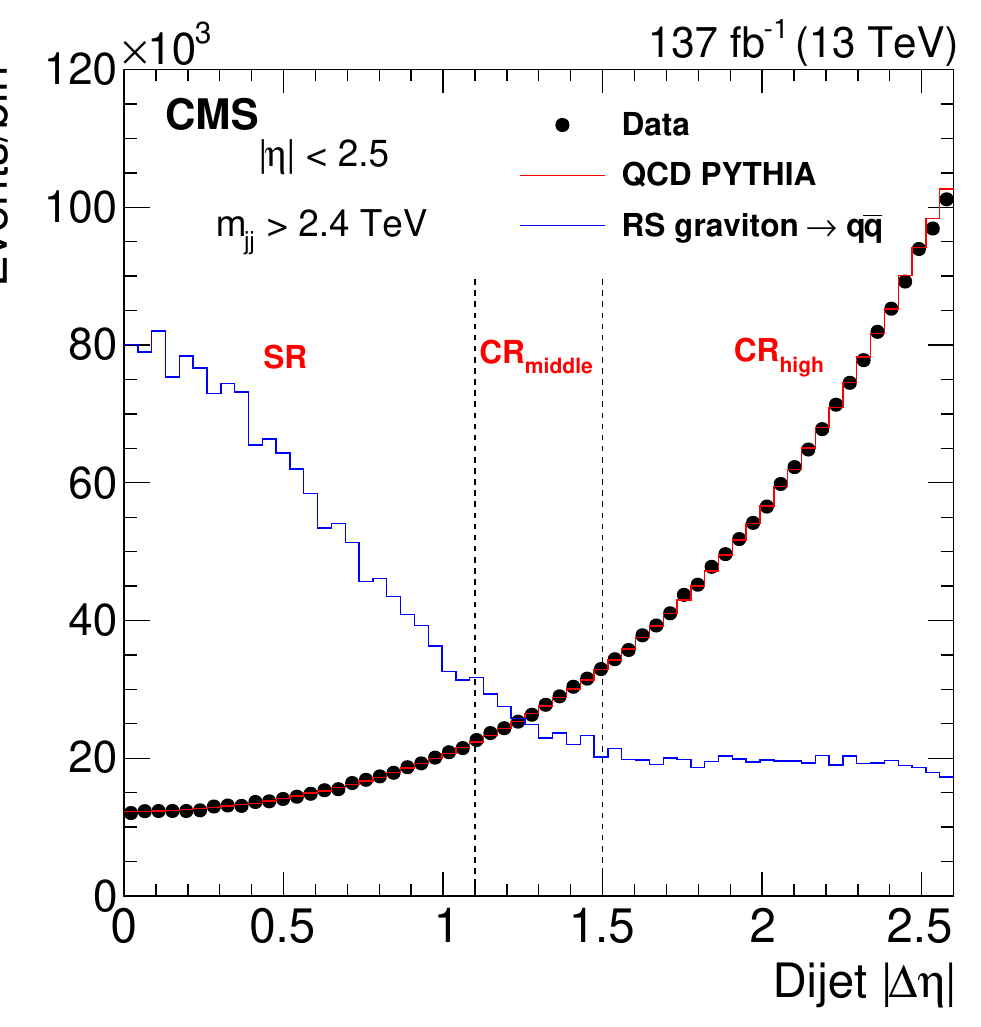
Figure 1 . The pseudorapidity separation between the two wide jets for the signal and control regions. Data (black points) are compared to QCD predictions from the pythia MC with detector simulation (red histogram) normalized to data. A signal from an RS graviton decaying into a qq pair is also shown (blue histogram) normalized to